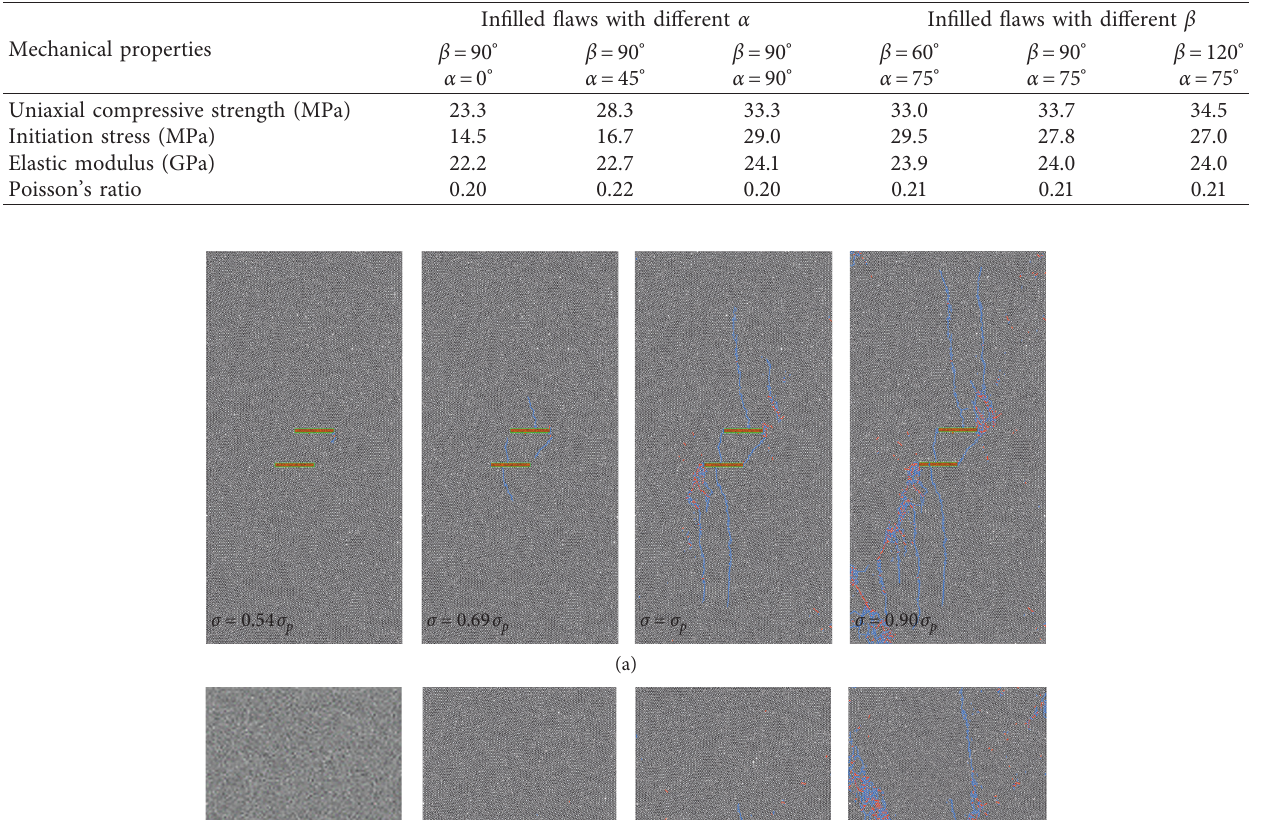
Table 4: Mechanical properties of samples with two parallel infilled flaws having different α and β .